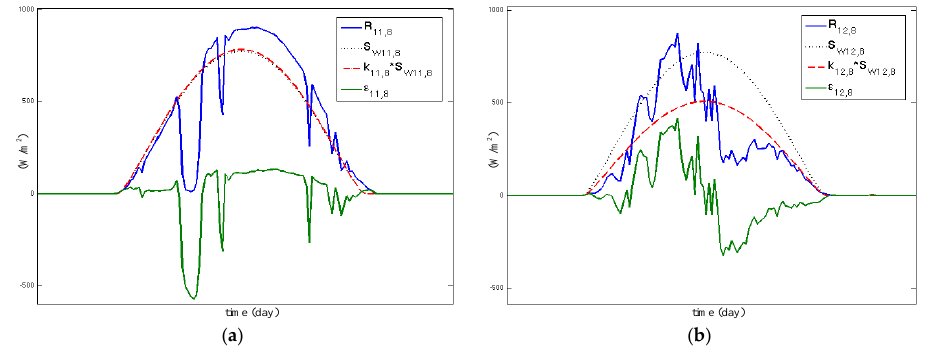
Figure 1. Profile of solar irradiance and its components, according to Equation (6), on ( a ) 11 August 2004; and ( b ) 12 August 2004.